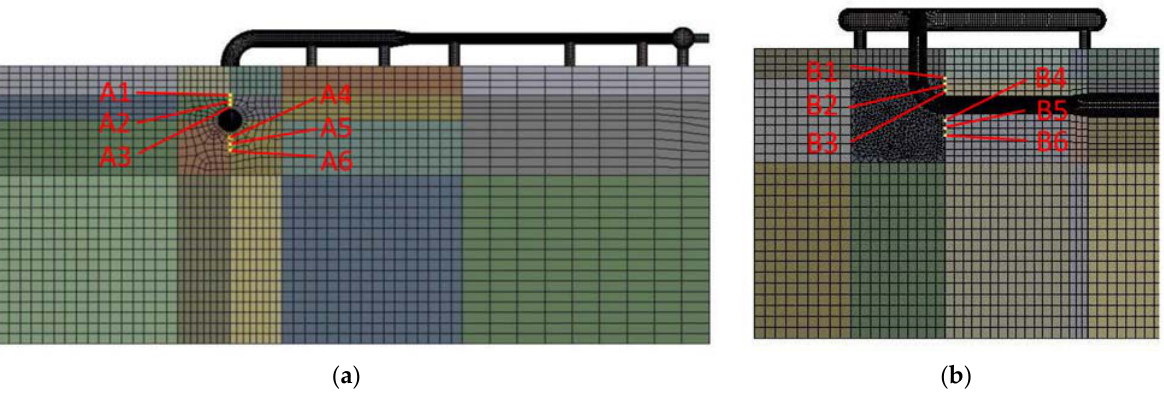
Figure 11. Plots of soil temperature around buried ascending pipe: ( a ) section A; ( b ) section B.